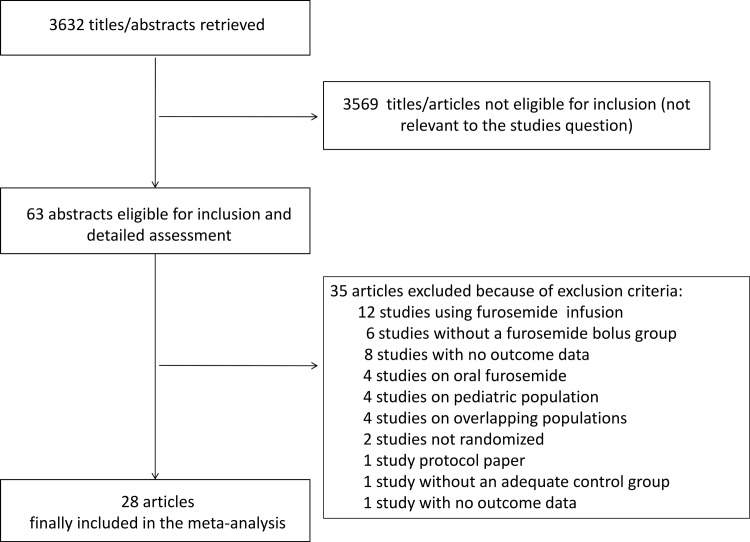
Examined studies.